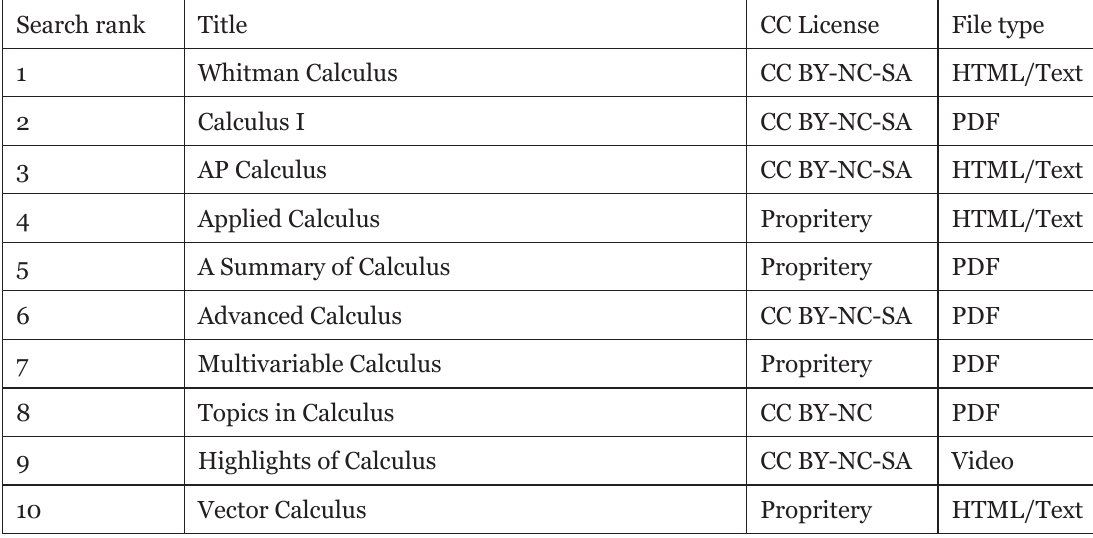
Top Ten Search Results Returned by OER Commons for the Keyword Calculus Search rank